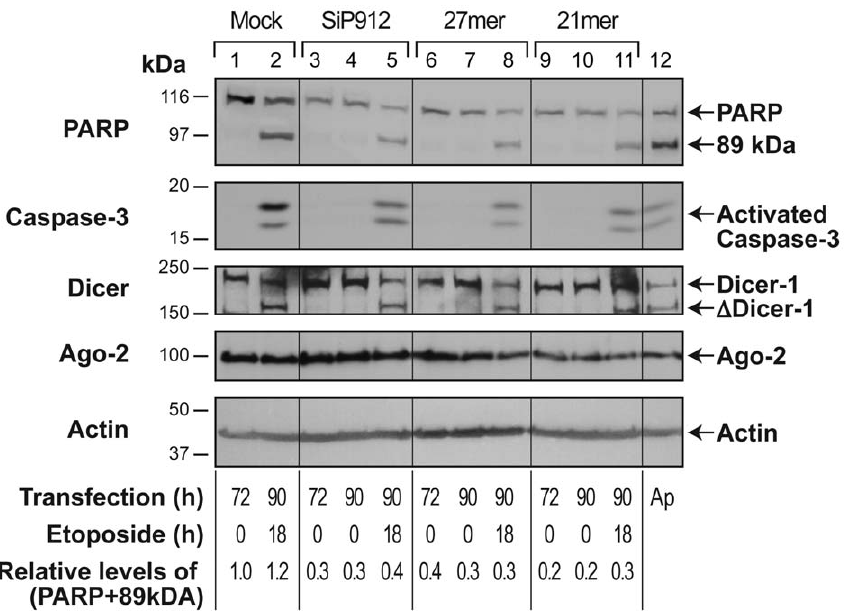
Figure 4. Persistence of transient RNAi of endogenous gene PARP during apoptosis in GM637 cells. The GM637 cells were transiently transfected with three RNAi-inducing agents: shRNA-generating DNA vector-SiP912, 27mer dsRNA or 21mer dsRNA or mock pCMV vector as control. At 72 h after transfection, cells were treated with 100 m M etoposide or with solvent control for 18 h and samples were harvested for immunoblotting for PARP, activated caspase-3, Dicer-1 and Ago-2. The actin probing served as loading controls and Ap refers to apoptotic cell extract prepared from etoposide-treated HL-60 cells. The (PARP + 89-kDa) signals from each sample are expressed as relative to untreated control in lane 1. The results shown in all three above panels are representative of 3–5 independent experiments with identical